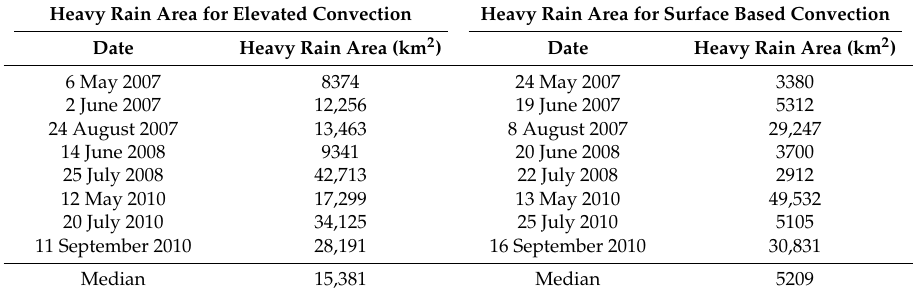
Table 3. Extent of the heavy rainfall areas (km 2 ) for elevated convection events (left) and surface based convection events (right).